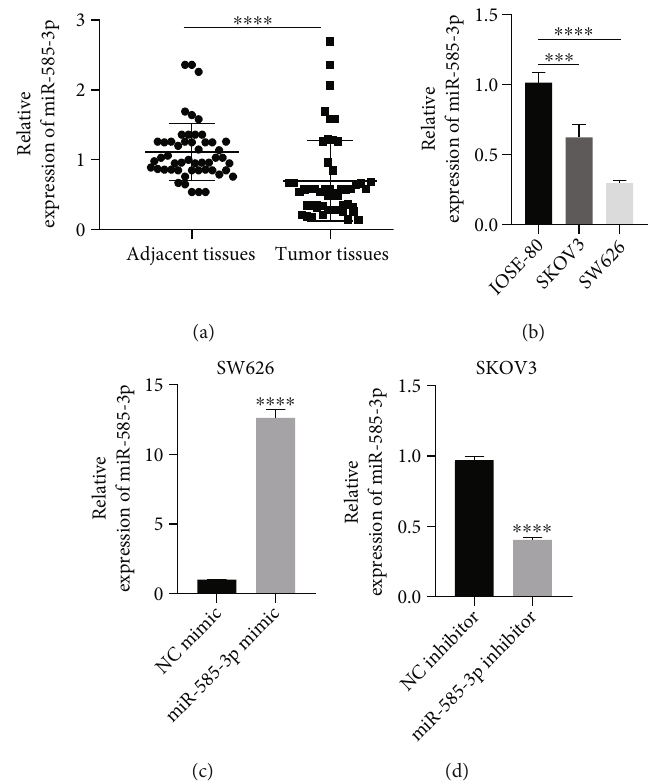
Figure 1: Low expression of miR-585-3p in ovarian cancer. (a) The expression of miR-585-3p in OC tissues and adjacent tissues. (b) RT-qPCR assays to detect the expression of miR-585-3p in OC cells SKOV3, SW626, and human normal ovary cell IOSE-80. (c) The relative expression of miR-585-3p in the SW626 cells after transfection of miR-585-3p overexpression. (d) The relative expression of miR-585-3p in the SKOV3 cells after transfection of miR-585-3p knockdown. ∗∗∗ P < 0 : 001 and ∗∗∗∗ P < 0 : 0001